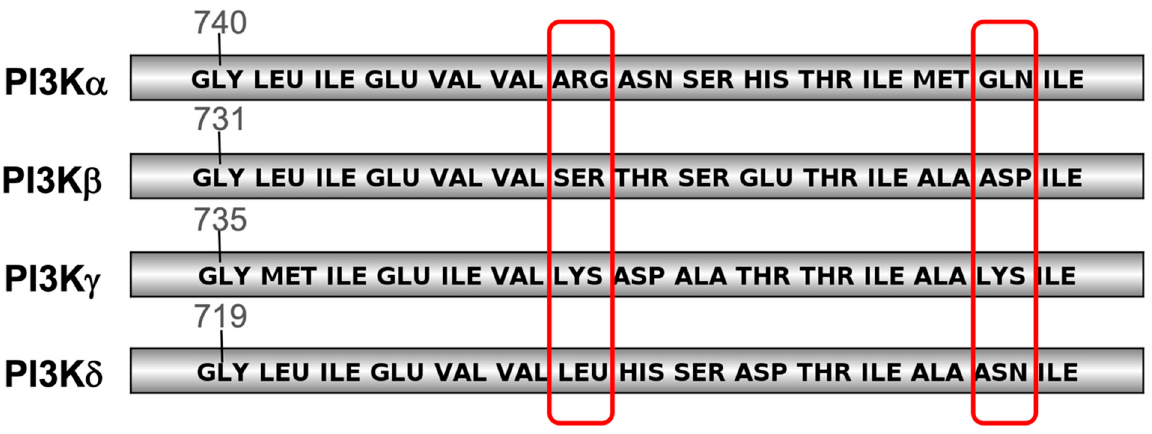
Figure 1. Binding pocket insights into PI3K isoforms. Sequence alignment indicates the conserved and variable residues in each PI3K isoform [21].